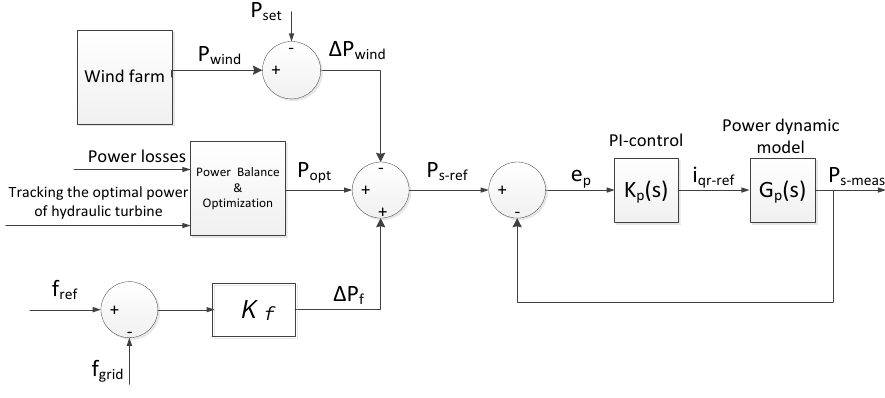
Figure 6. A rotor-side converter of active power control structure.